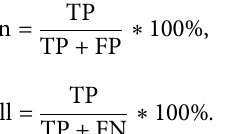
Figure 9: DAWM module